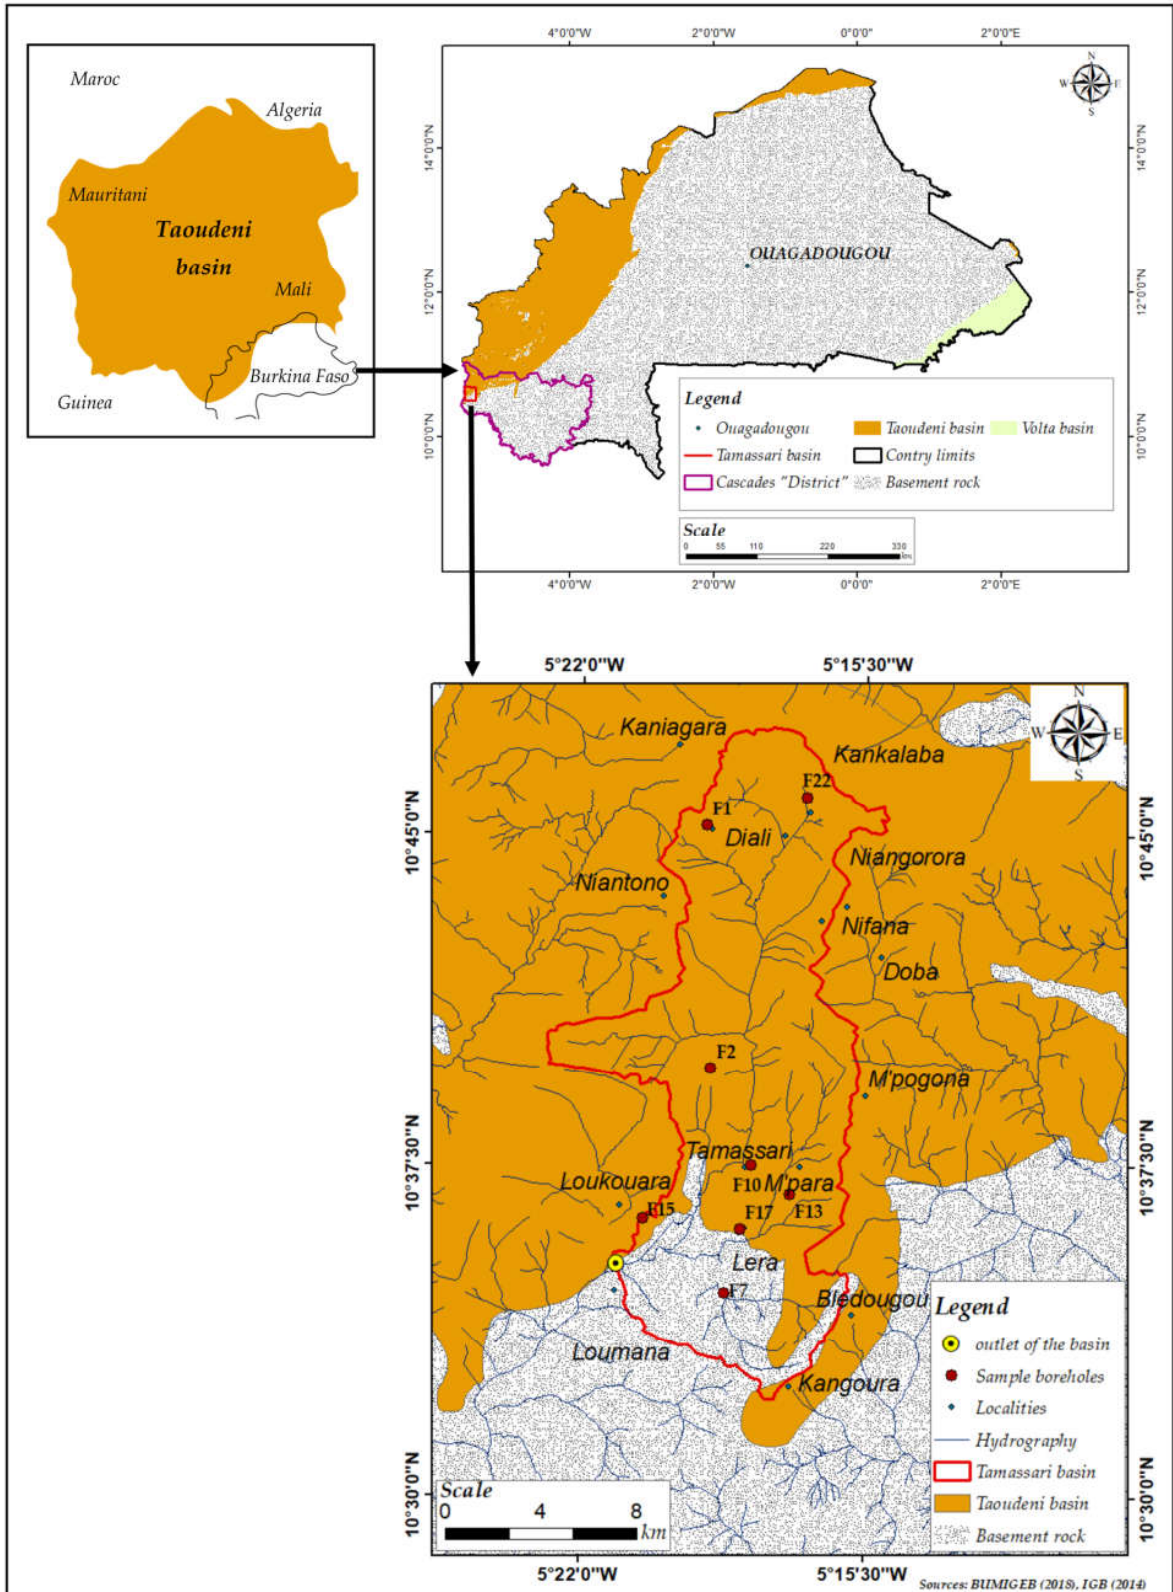
Figure 1. Location and geology of the study area.